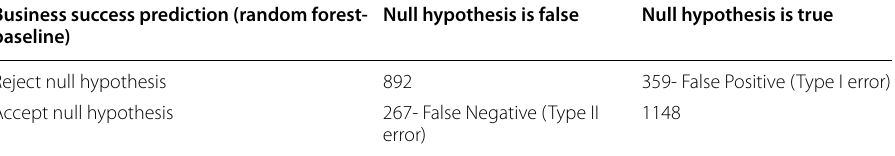
Table 8 Type I and Type II hypothesis testing error-proposed IBM method Business success prediction (random forest‑ baseline)